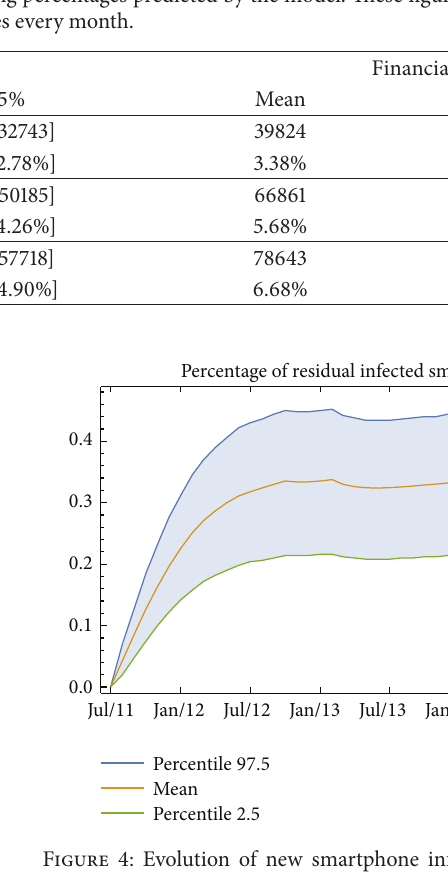
Figure 3: Model evolution of the cumulative smartphone infections every month since July 2011 until December 2014. The line in the middle is the mean and those up and down correspond to 95% confidence interval.